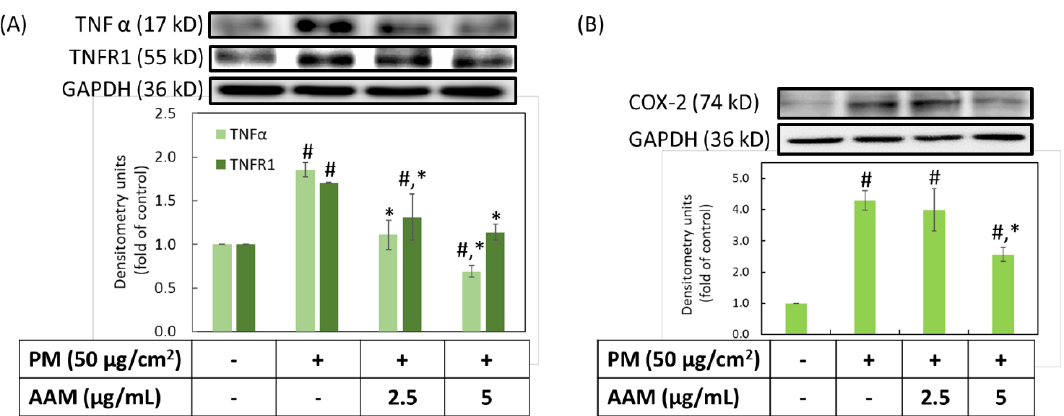
Figure 4. Effect of AAM on PM-induced inflammatory protein expressions in HaCaT cells, TNF α and TNFR1 ( A ) and COX-2 ( B ). Data were from three independent experiments. Value are mean ± SD ( n = 3). # Significantly different from control group ( p < 0.05); * Significantly different from PM treatment alone ( p < 0.05).